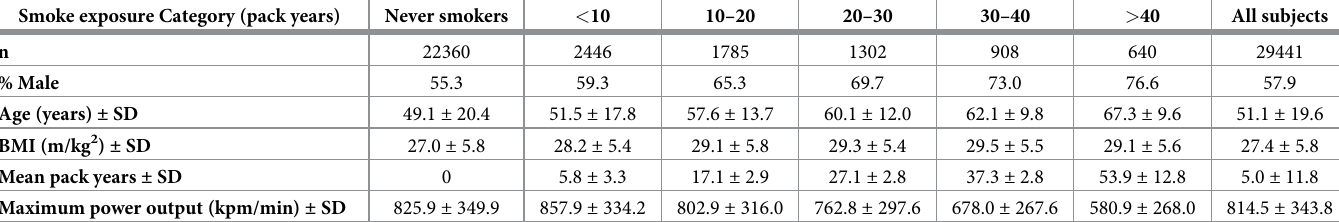
Table 1. Demographics of study